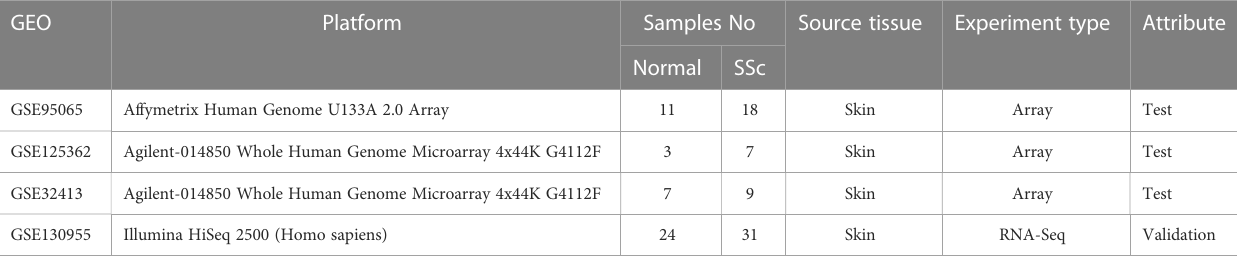
TABLE 1 The details of selected